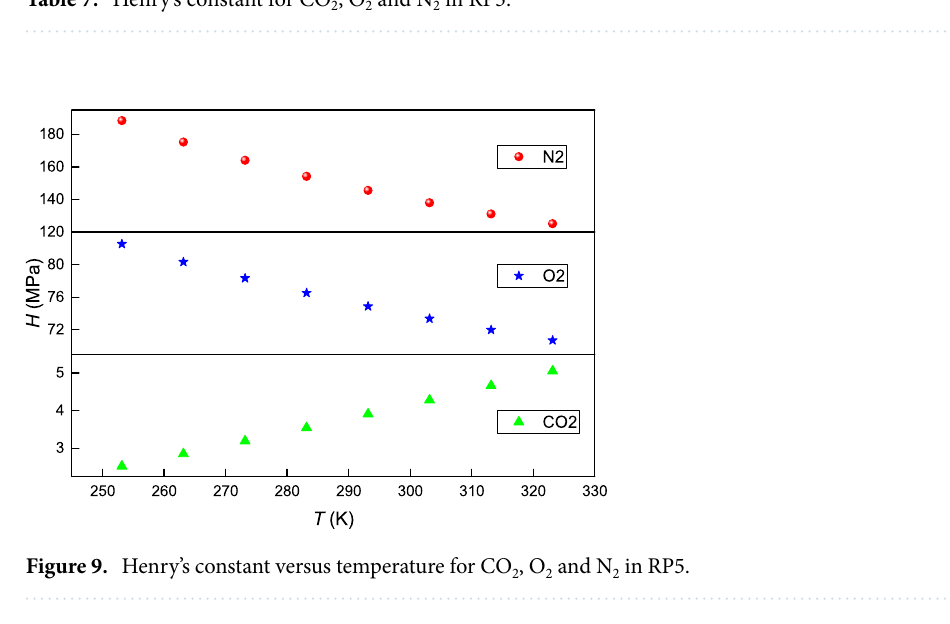
Table 7. Henry’s constant for CO 2 , O 2 and N 2 in RP5.